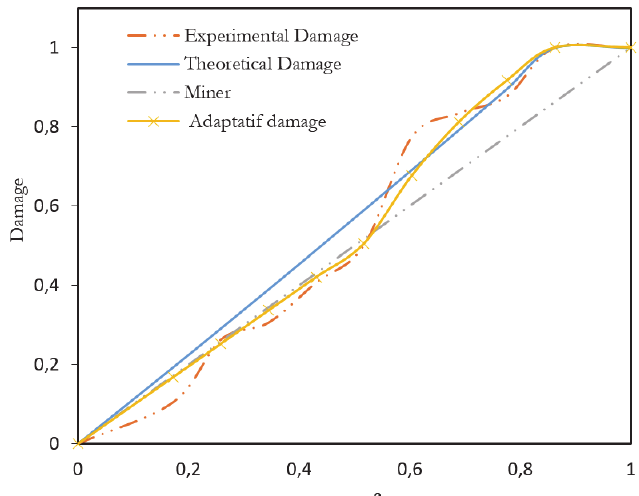
Figure 8: Approximate theoretical damage, through corrected Faupel, adaptive and experimental damages according to the life fraction. The representation of the continuum damage model is almost the same as the one given by the adaptive damage model as illustrated in Fig. 8. The difference is explained by taking into account the applied experimental pressure (Pa = 11.9 bar) for the continuum damage model independently of the theoretical equations.